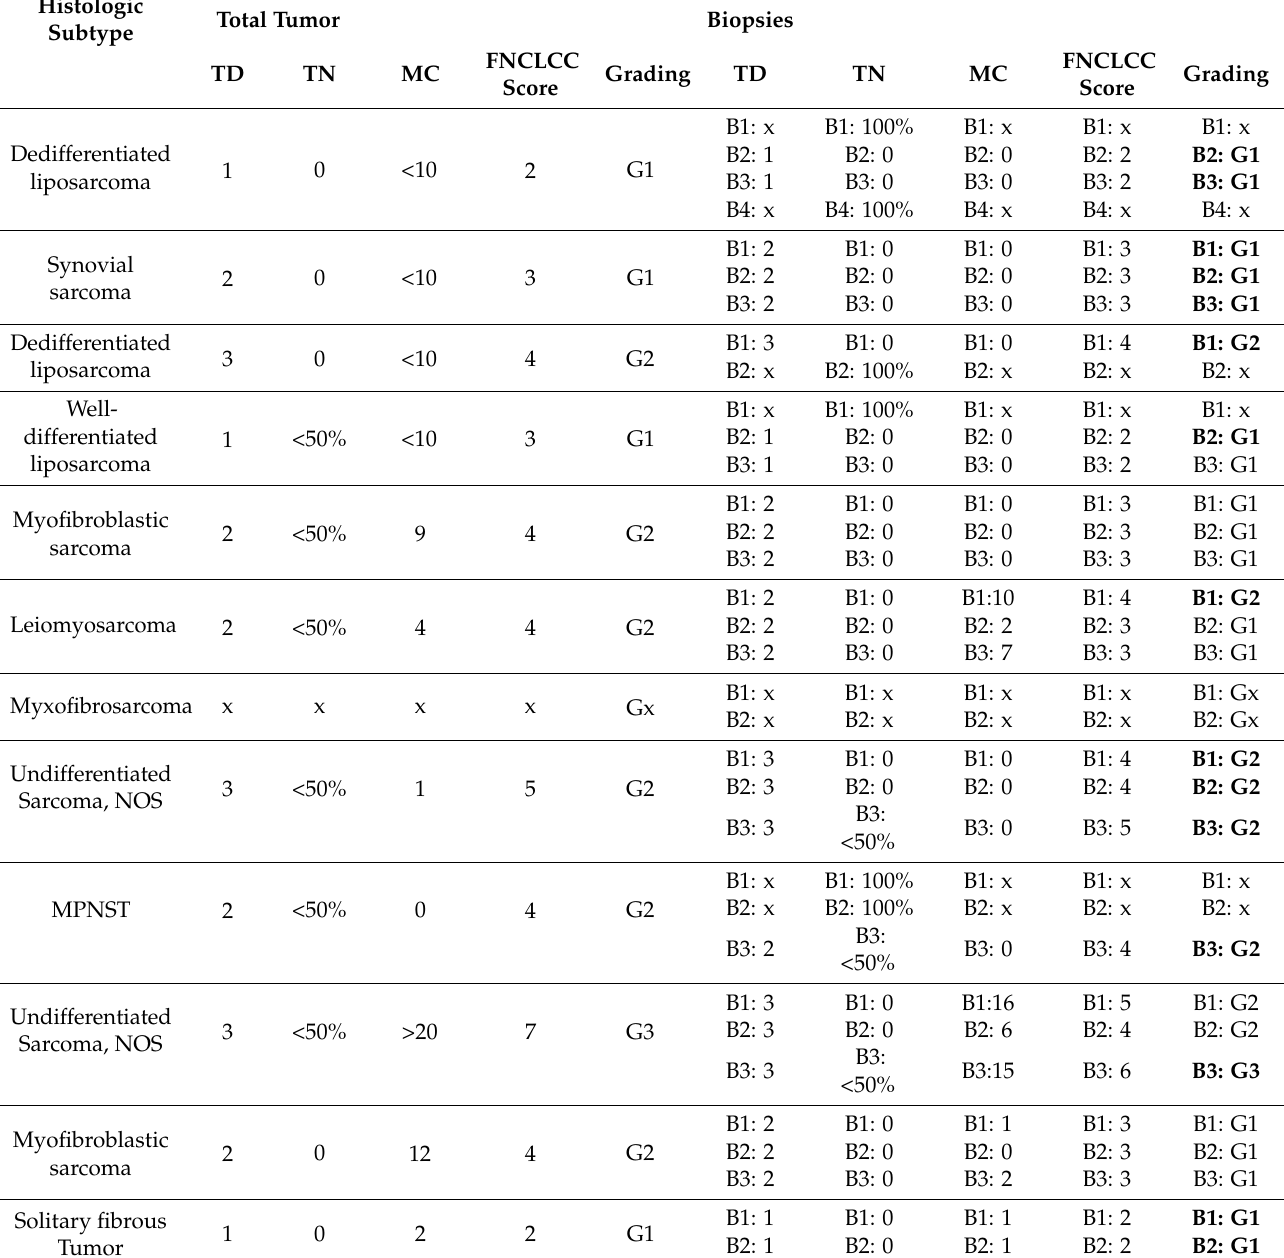
Table 2. Histological subtype and grading according to FNCLCC criteria of all total tumors and biopsies. The biopsies graded in concordance with the total tumor are highlighted in